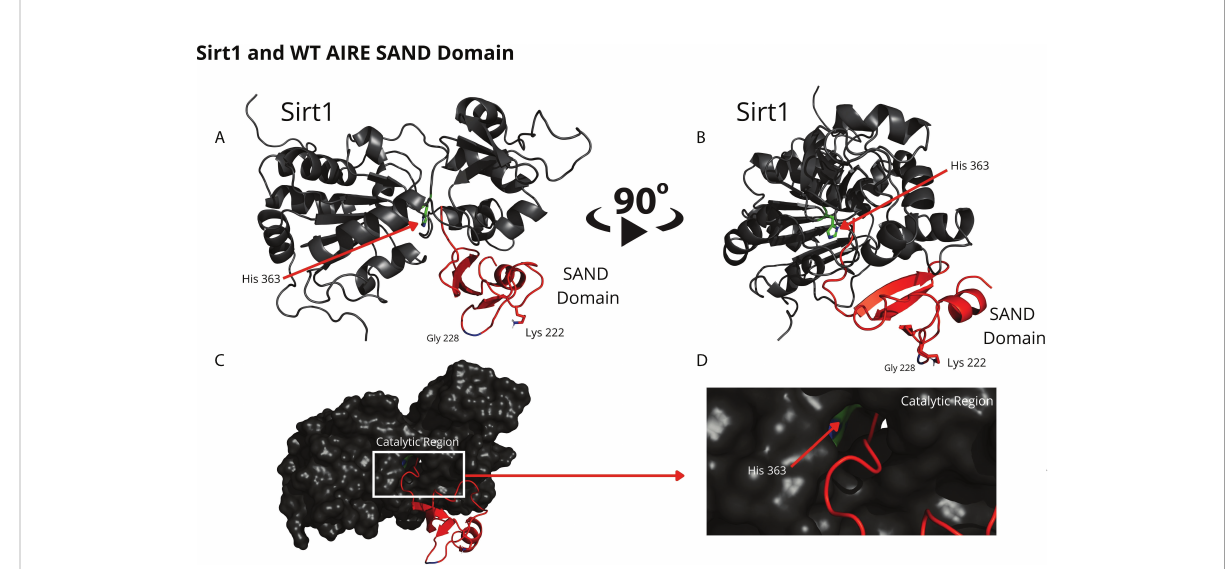
FIGURE 2 The blind docking output of the wild-type AIRE SAND domain shows that this domain interacts with the catalytic region of the SIRT1 protein. In (A, B) the structures of the WT SAND domain (in red) and SIRT1 (in dark gray) are represented. In this representation, the AIRE SAND domain interacts with the catalytic region through its terminal loop, and the glycine 228 (Gly228) and lysine 222 (Lys222) residues are presented with their side chains. Without the Lys222 acetylated, this formation is incompatible with the native structure of the complex formed with the complete AIRE protein, in which this loop does not exist. In (C, D) the same complex is represented with the surface of SIRT1 highlighted. (D) represents the catalytic region of SIRT1 and its catalytic residue,